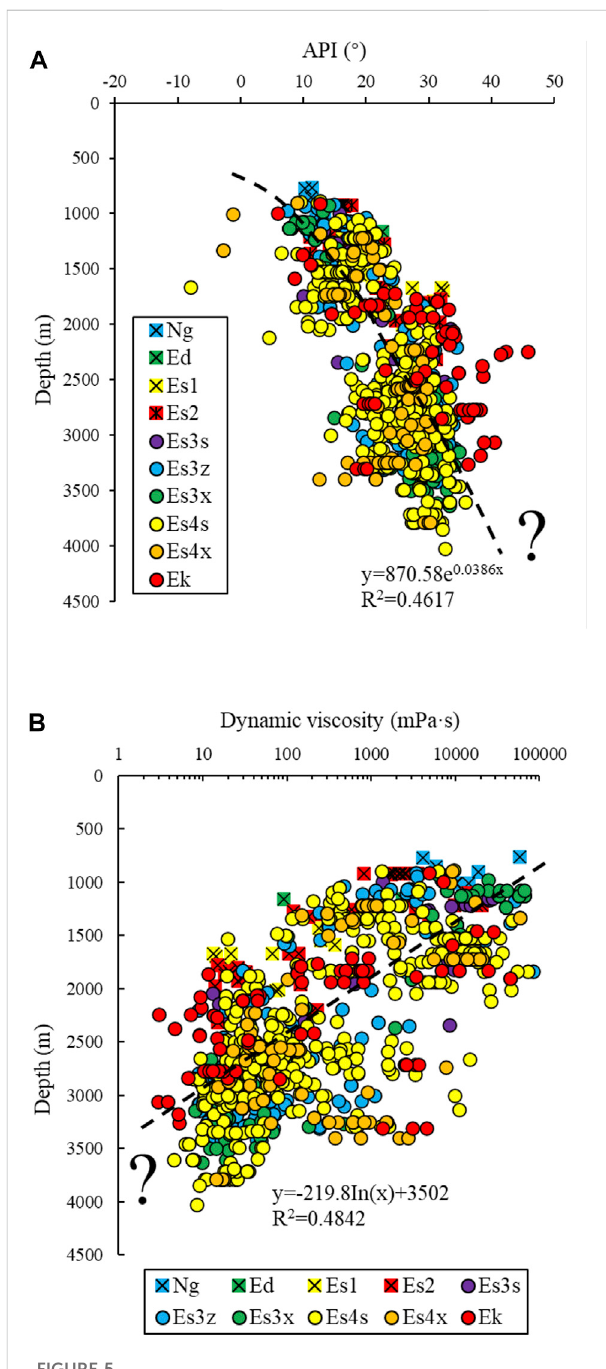
FIGURE 5 Trends of (A) API gravity and (B) dynamic viscosity of oil samples with present-day reservoir depth.